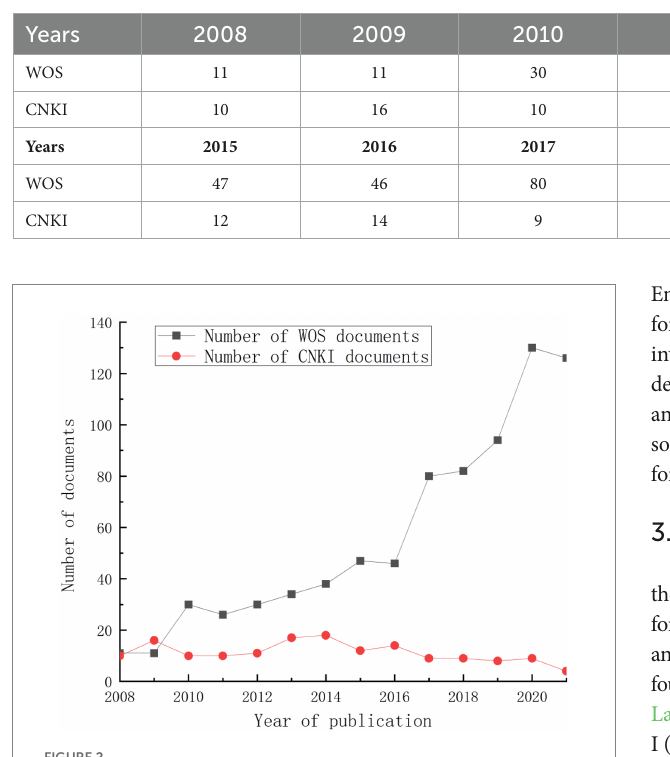
FIGURE 2 Annual statistical chart of literature related to climate migration research (2008–2021).